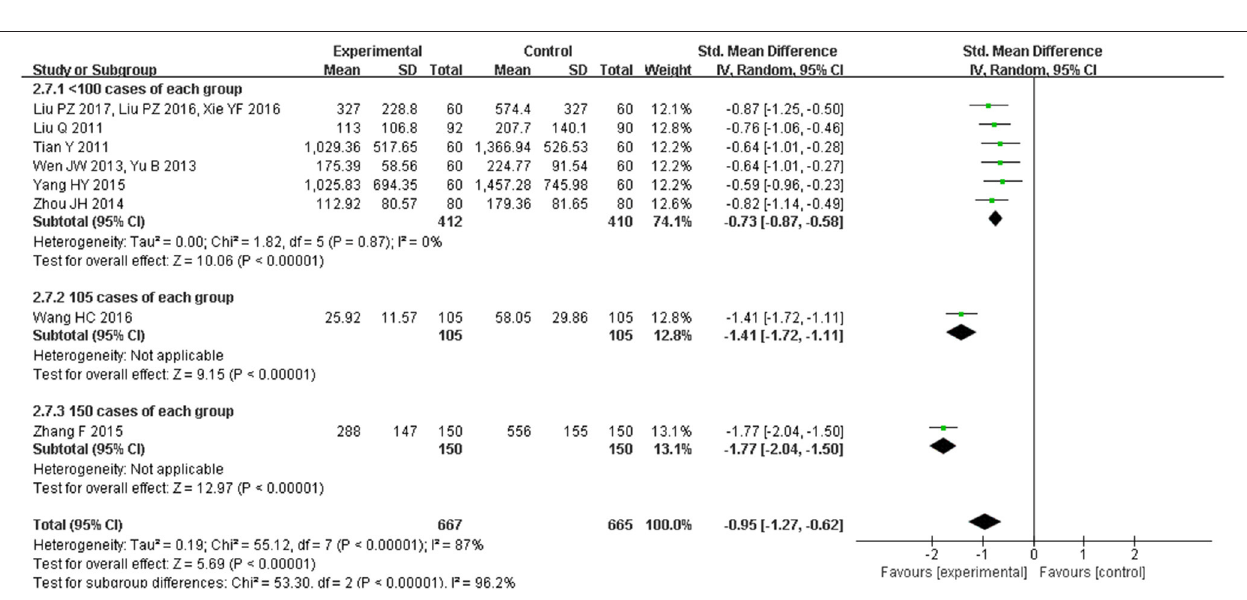
FIGURE 9 | Pooled and individual estimates of standard mean difference (SMD), and 95% CI of BNP for CHM, and control therapies.